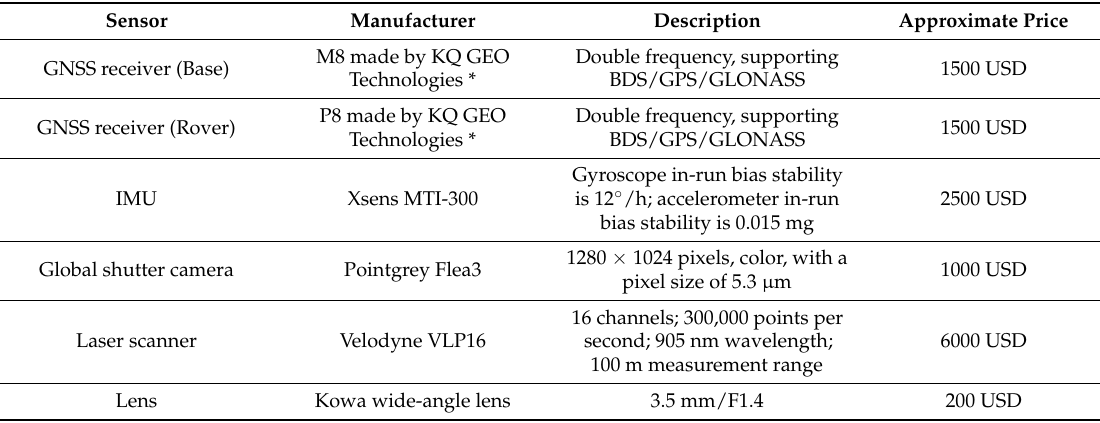
Figure 2. System description of the Kylin Cloud. Table 1. Sensor specifications of the Kylin